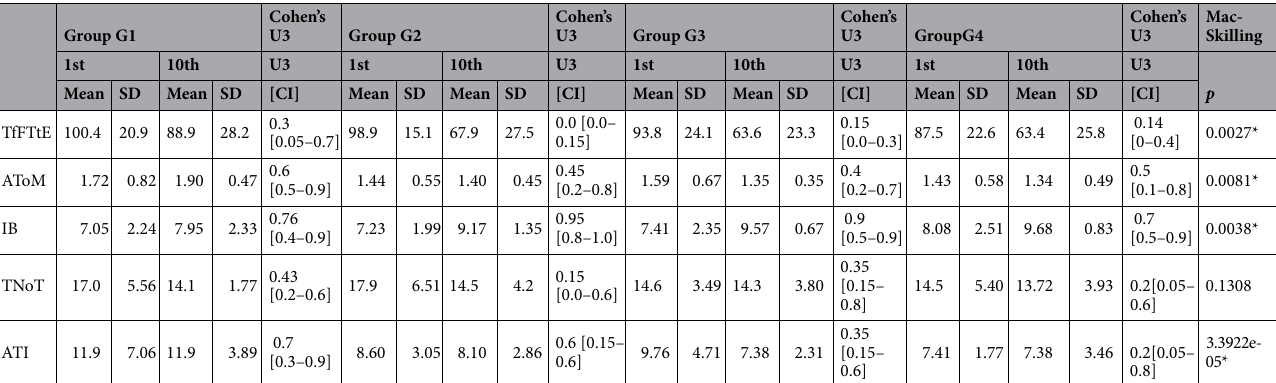
Table 2. The mean outcomes of the TfFTtE (Time from first touch to the end), AToM (Average time of manipulation), IN (Inserted boxes), TNoT (Total number of tries) and ATI (Average tremor indicator) at 1st and last session. The Mac-Skilling non-parametric test was used to test the statistical differences (group x time, p < 0.05). Cohen’s U3 demonstrated the size effect between 1st and 10th session. *Statistically significant differences ( p <